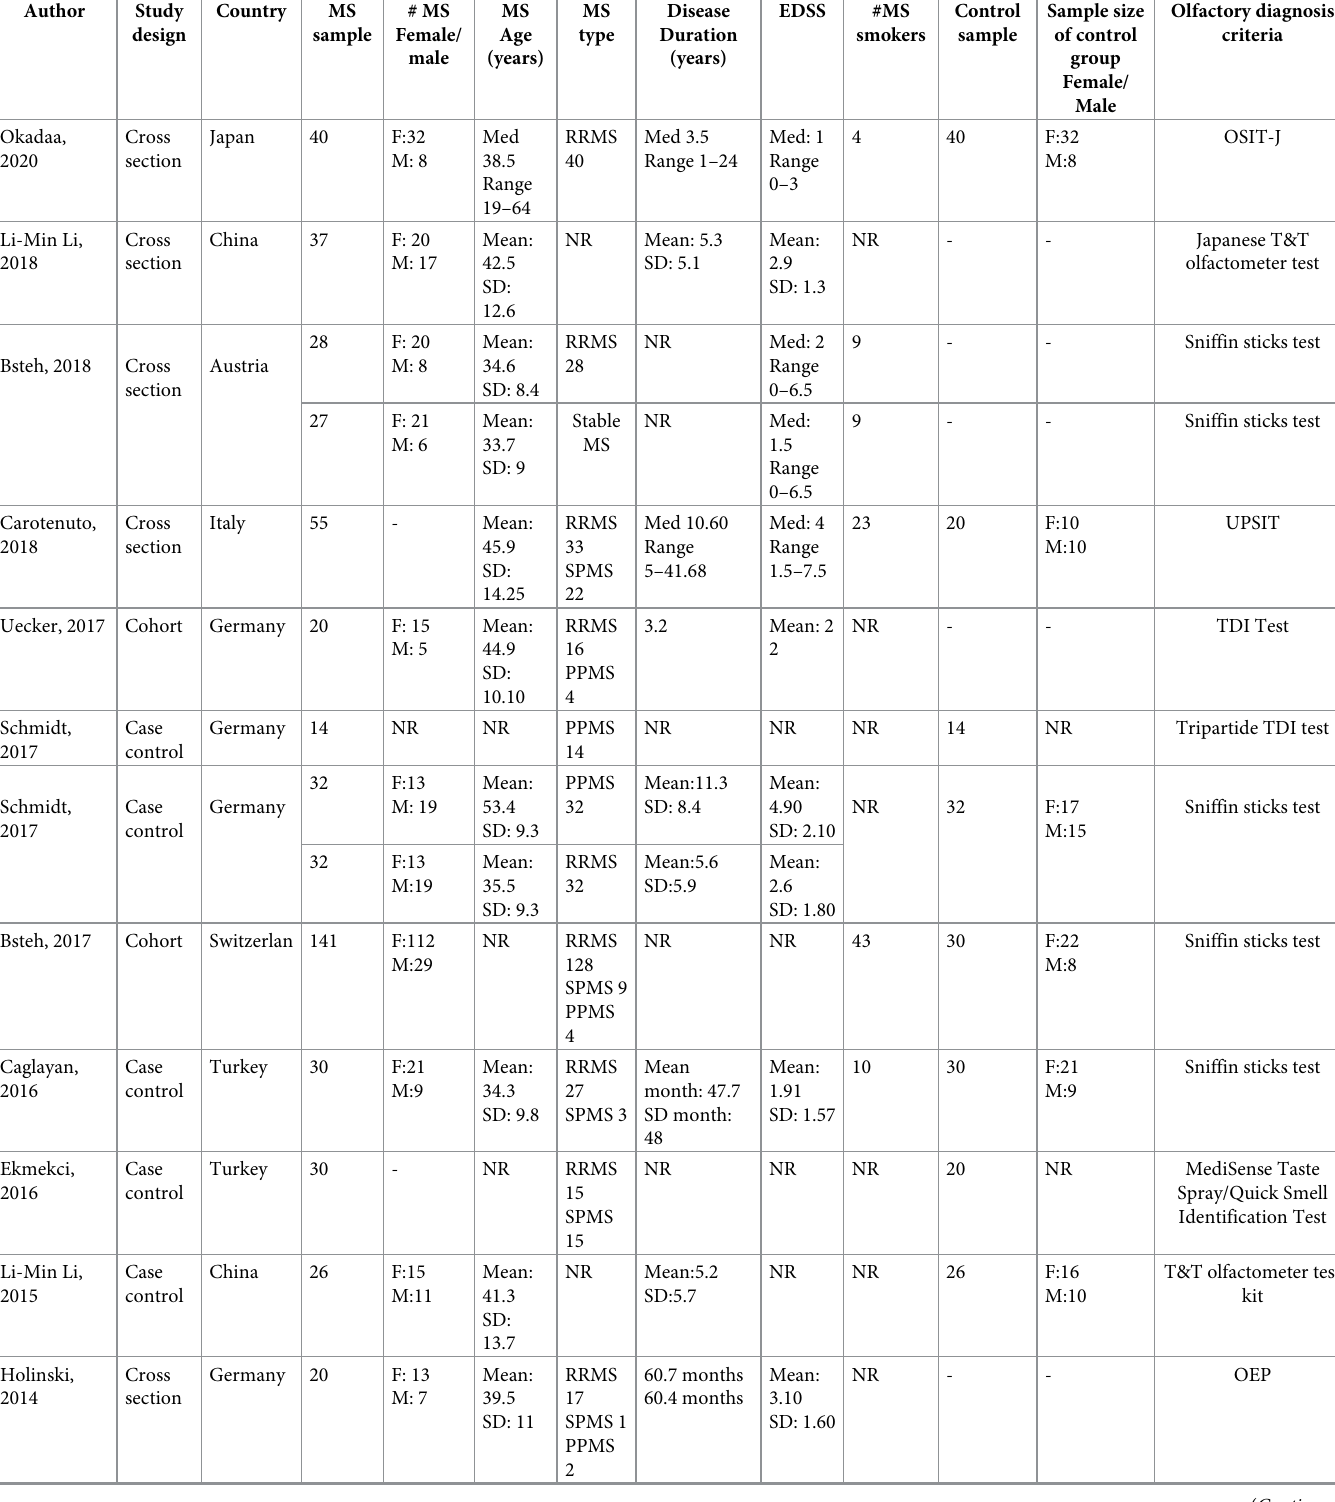
Table 1. Basic characteristics of the included